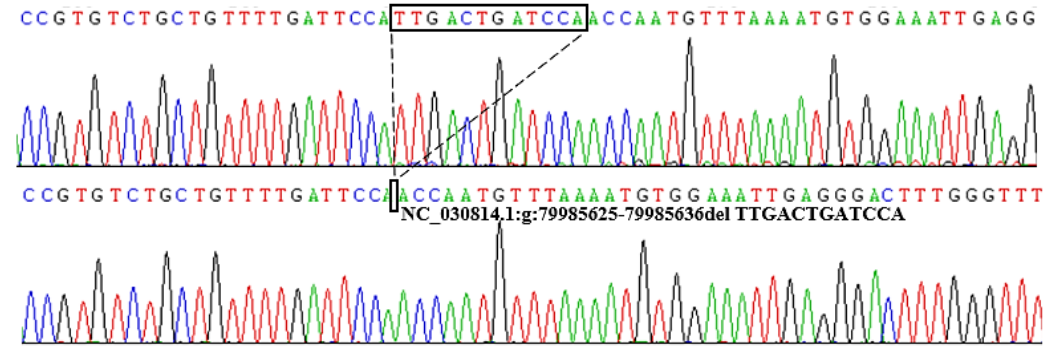
Figure 3. Sequencing diagram of the 12 bp deletion locus within the goat PRDM6 gene. The sequence within the black border shows the difference in the sequence fragment.